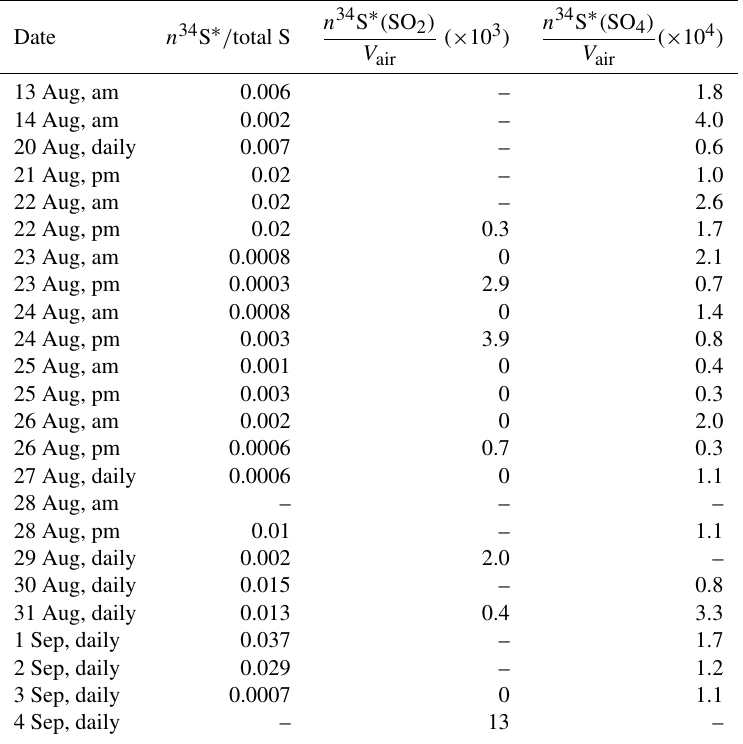
Table A1. The fraction of enriched 34 S in sulfate samples in the size range F < 0 . 49µm and the number of enriched sulfur moleculescm − 3 molecules (S) ) for SO 2 and sulfate during CIMS-ON ( cm 3